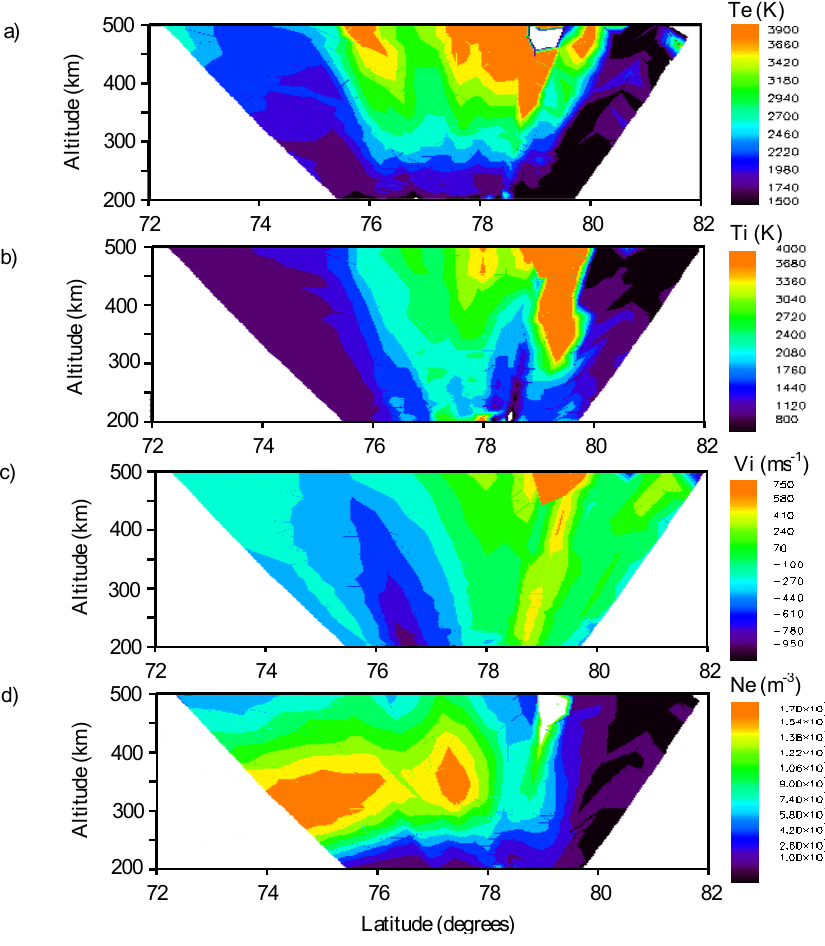
Fig. 3. (a) Electron temperatures, (b) ion temperatures, (c) line-of-sight ion drift velocities and (d) electron densi- ties measured by the ESR radar during a NOON scan between 09:30UT and